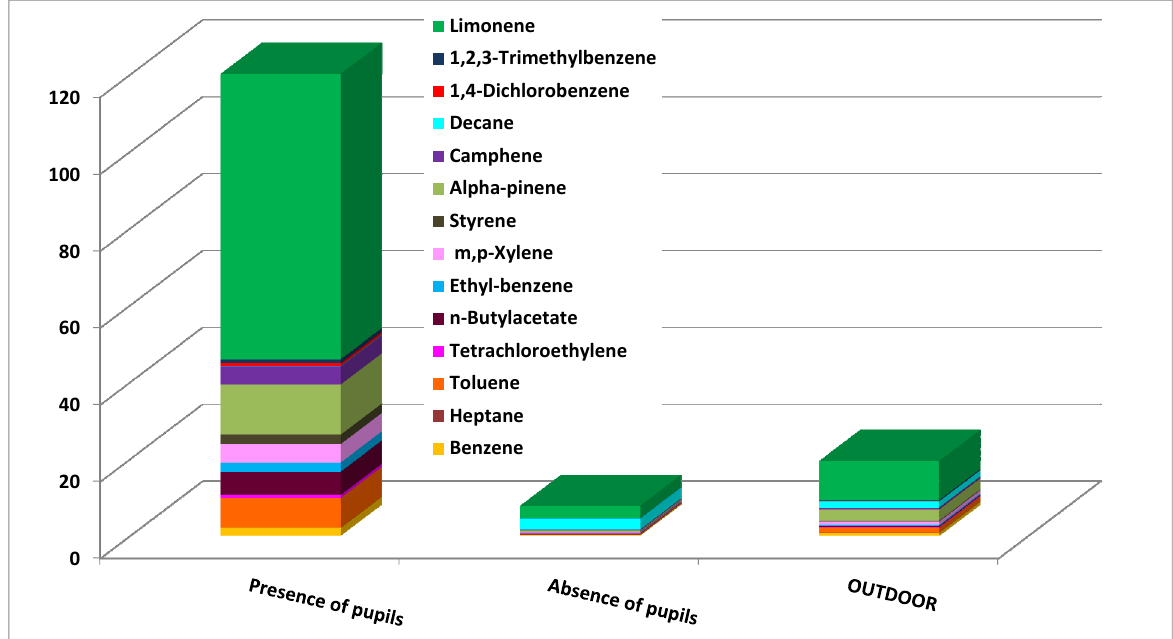
Figure 7. VOC concentration in classroom 2, school 2 in presence and in absence of